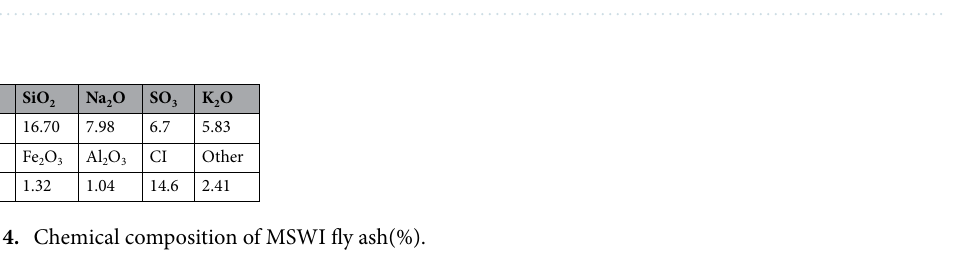
Table 3 indicates that phosphogypsum is mainly composed of C, S, O and other oxides, among which the content of active ingredients such as CaO and SiO 2 is as high as 33%. Refer to Chinese specification (GB/T 9776- 2008) 33 , phosphogypsum has the property of self-cementing curing.